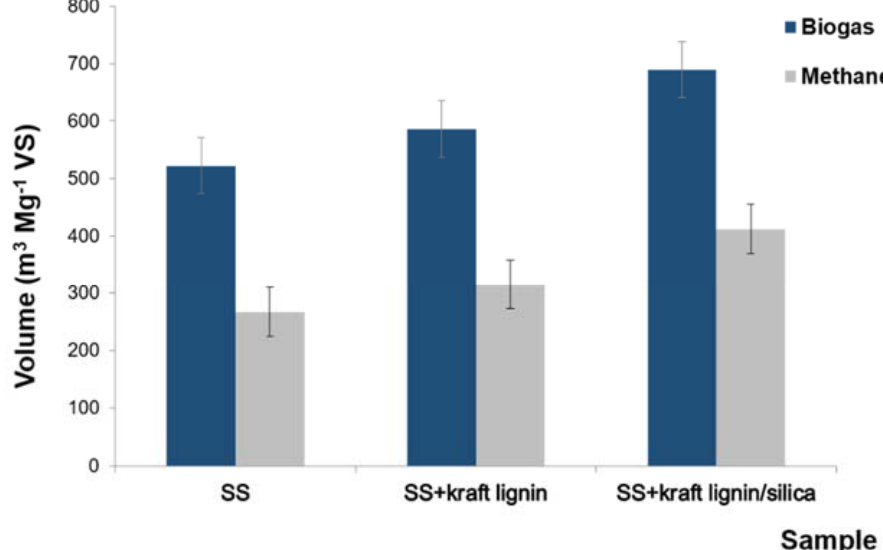
Figure 15. The e ffi ciency of biogas and methane production per Mg of volatile solids obtained from SS, SS + kraft lignin and SS + kraft lignin / silica